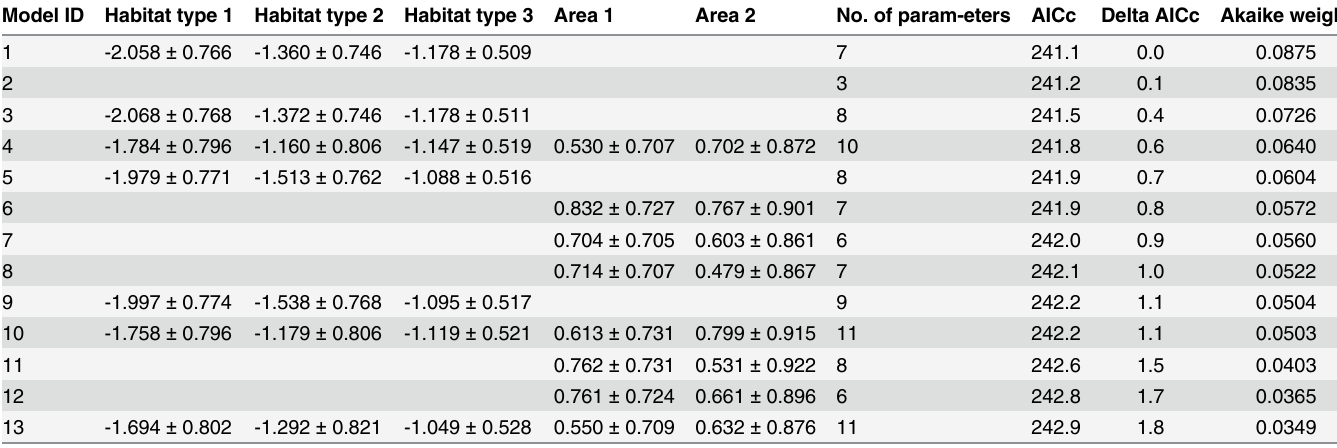
Table 4. Beta coefficients ± standard errors for the categorical) in the top 13 AICc models competing for first ranking model. Variables Habitat type (1 = Shrubland & Degraded forest; 2 = Teak stands; 3 = Tall forest; 4 = Community forest, reference category, not included) and Area (1 = Gunung besar; 2 = Payung-payung; 3 = Kumalasa, reference category, not